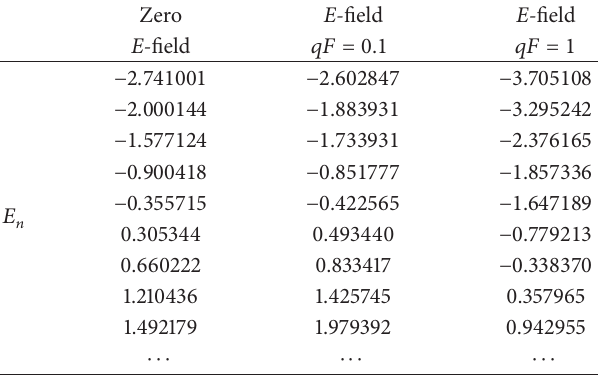
Table 2: Energy spectrum (first 9 values) for a complex